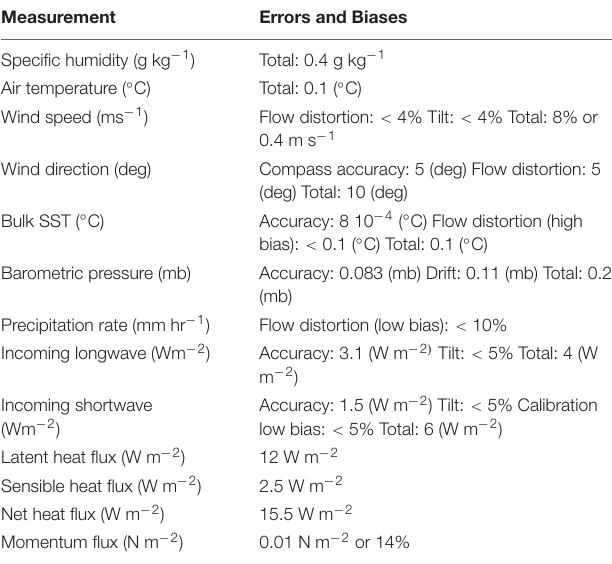
TABLE 1 | ASIMET measurement errors for daily averages on the NTAS buoy. Measurement Errors and